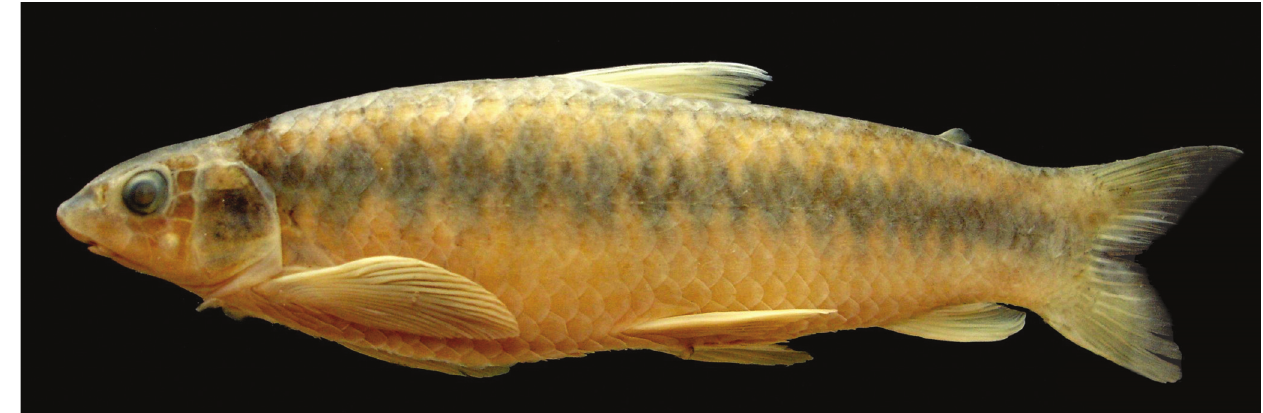
Fig. 1. Parodon alfonsoi , Holotype, CIUA 1125, 103.4 mm SL. Colombia, Tucuy River, tributary of the Calenturitas River, lower Magdalena, La Jagua de